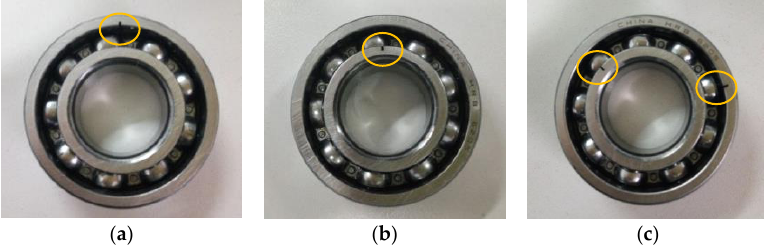
Figure 10. Photo of the faulty bearing: ( a ) outer race fault (ORF), ( b ) inner race fault (IRF) and ( c ) outer-inner race compound fault (OIRF).